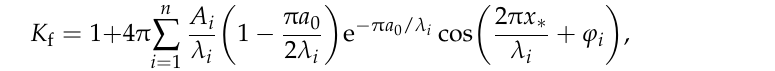
Figure 8. The SCFs and FNFs induced by surface topography for specimen B1.